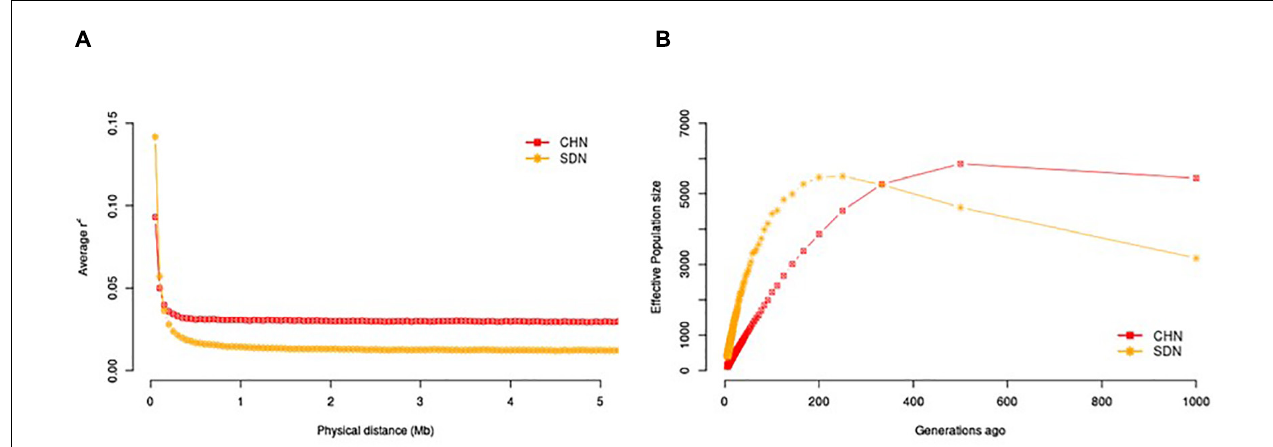
FIGURE 1 | (A) LD decay pattern within 5 Mb distance in Sudanese and Chinese sheep. (B) N E across 1,000 generations in Sudanese and Chinese sheep.